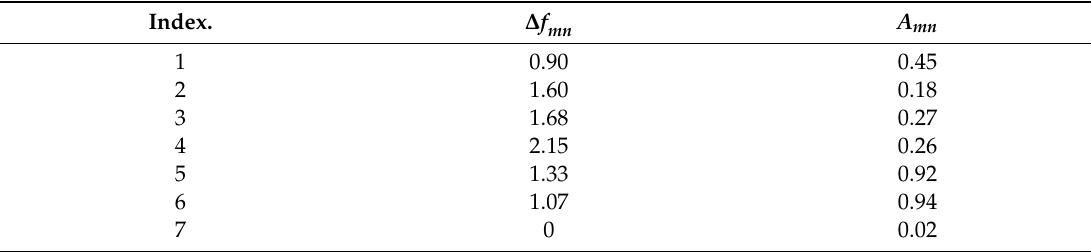
Table 2. Frequency offset and the amplitude offset.